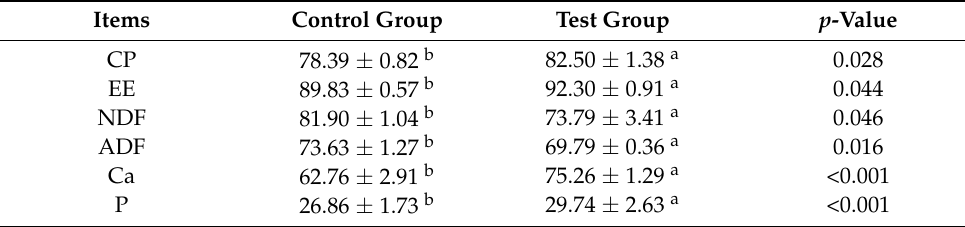
Table 4. Effect of concentrate supplementation on nutrient apparent digestibility of yak calves (Unit: %).